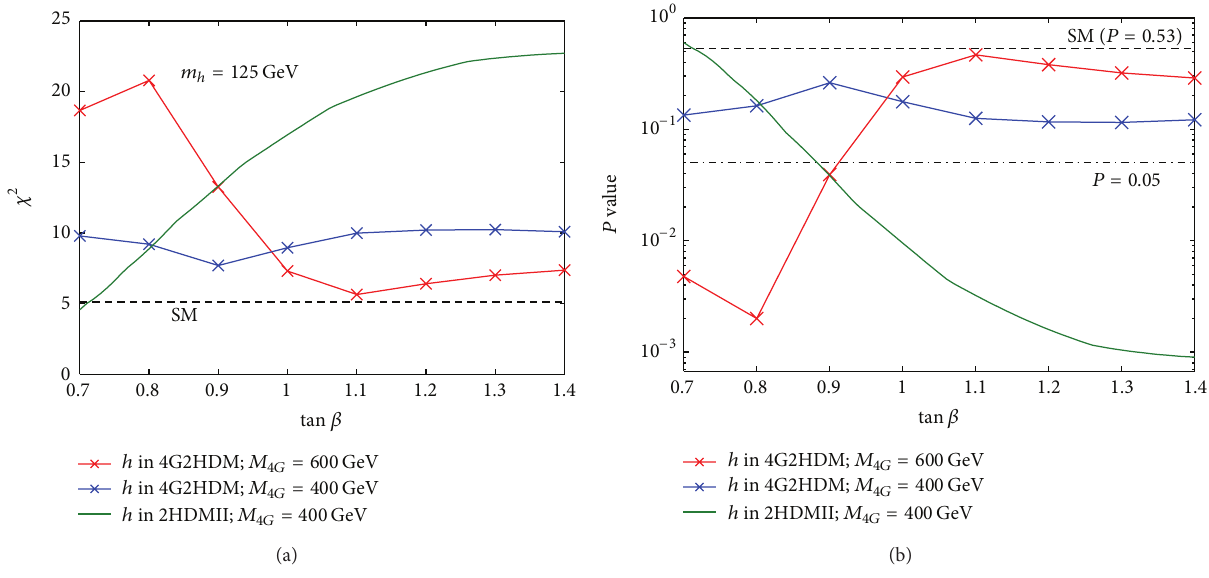
Figure 24: Same as Figure 23, while here we minimize with respect to both 𝜖 𝑡 and 𝛼 for each value of tan 𝛽 . Also shown are the 𝜒 2 and 𝑃 values for a 125 GeV Higgs in the SM and in the type II 2HDM with a 4th generation of fermions (denoted by 2HDMII). Figure taken from [157].